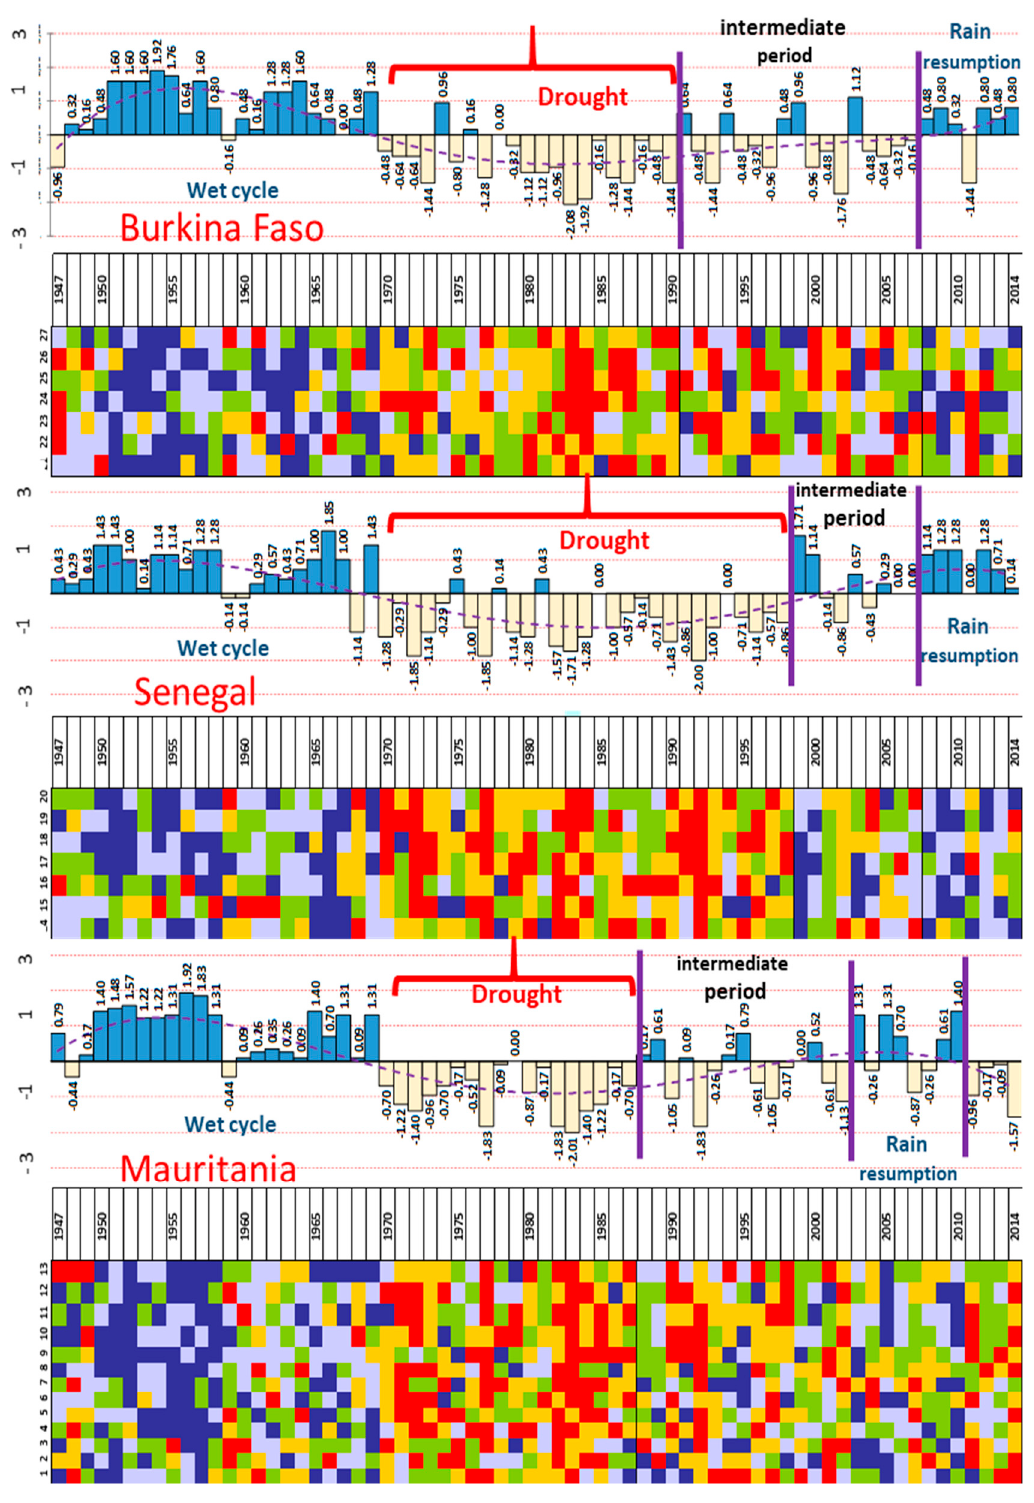
Figure 2. Chronological graphical matrix of data processing applied to rainfall (1947–2014).